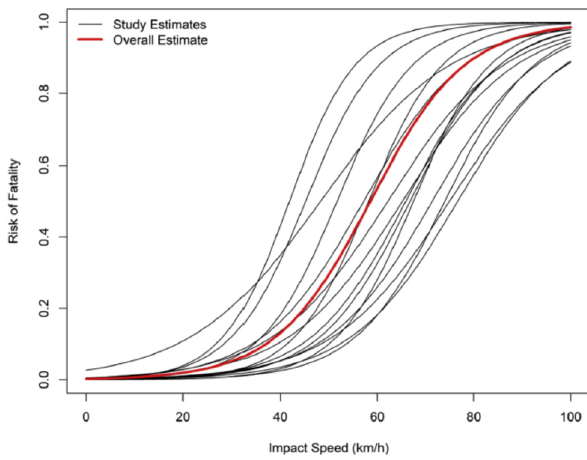
Figure 1: Plot for S - shaped curves for pedestrian fatality risk by impact speed [ 11 ]